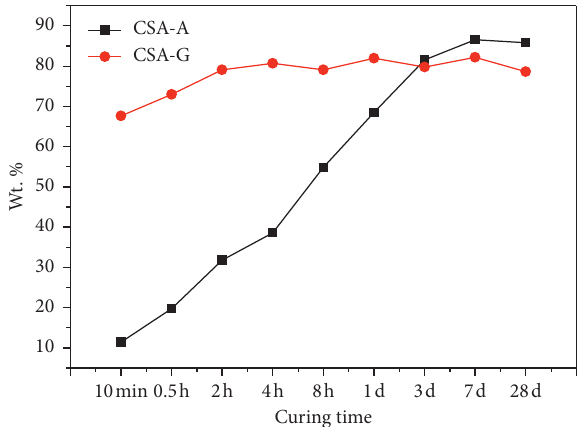
Figure 7: Change regulation of ettringite quantity with curing